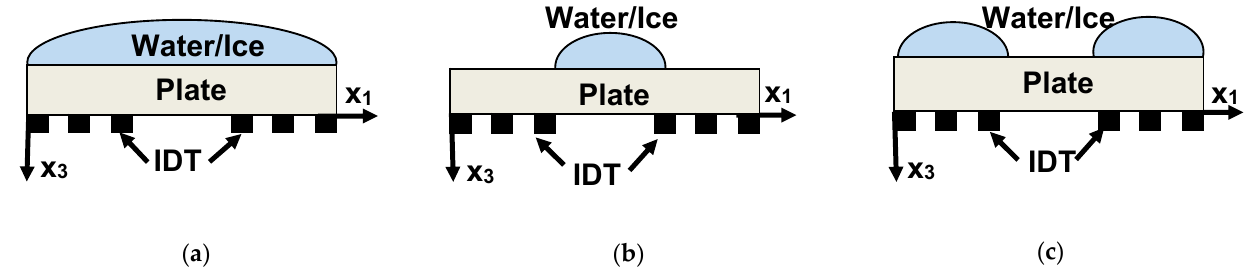
Figure 2. Delay line structures used for the analysis of the partial contributions to the Lamb wave water or ice response. ( a ) Water or ice is deposited on the entire surface of the plate, ( b ) surface of the plate between IDTs ( c ) surface of the plate over IDTs.